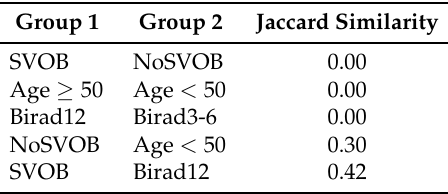
Table 6. Population comparison. Reporting Jaccard similarity of sets of patient ids in the two groups. Note that the population is independent of the number of events considerd, i.e., cases Birad12 and 2-Birad12 are equivalent in terms of patients.